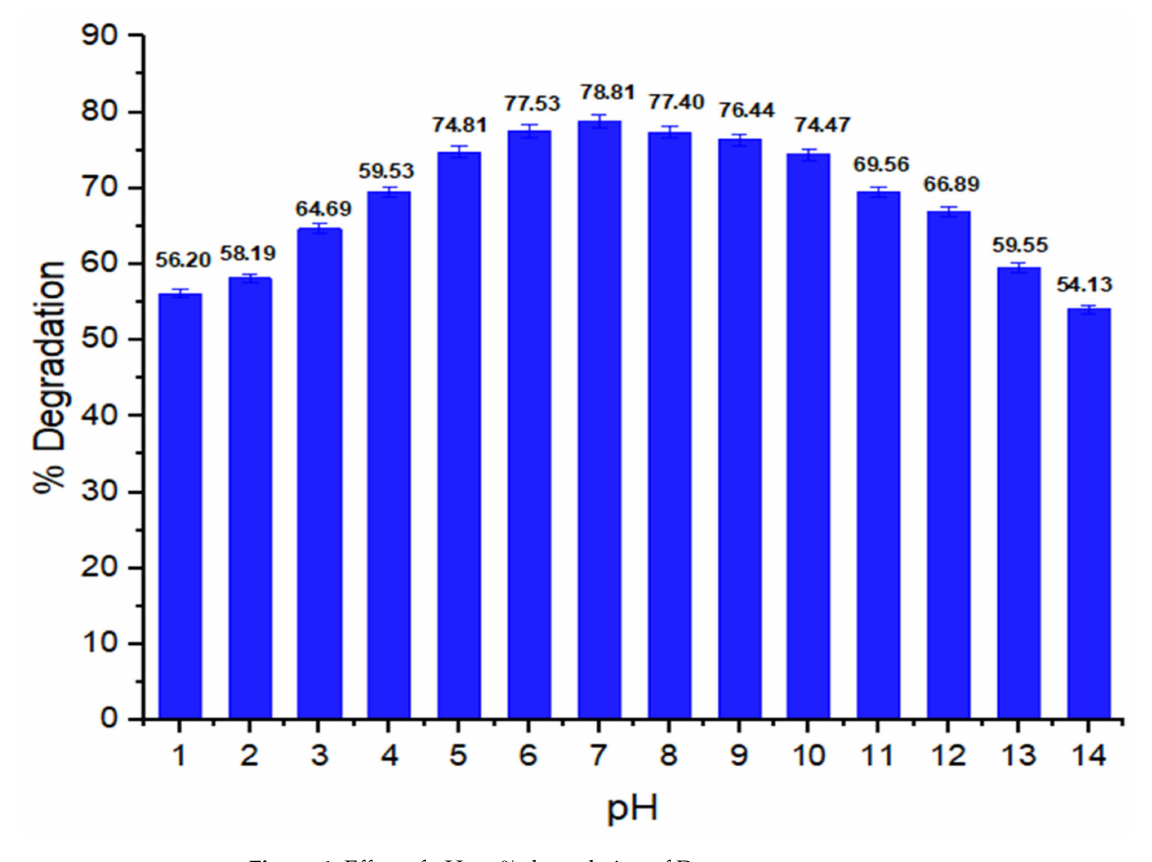
Figure 4. Effect of pH on % degradation of Dye.